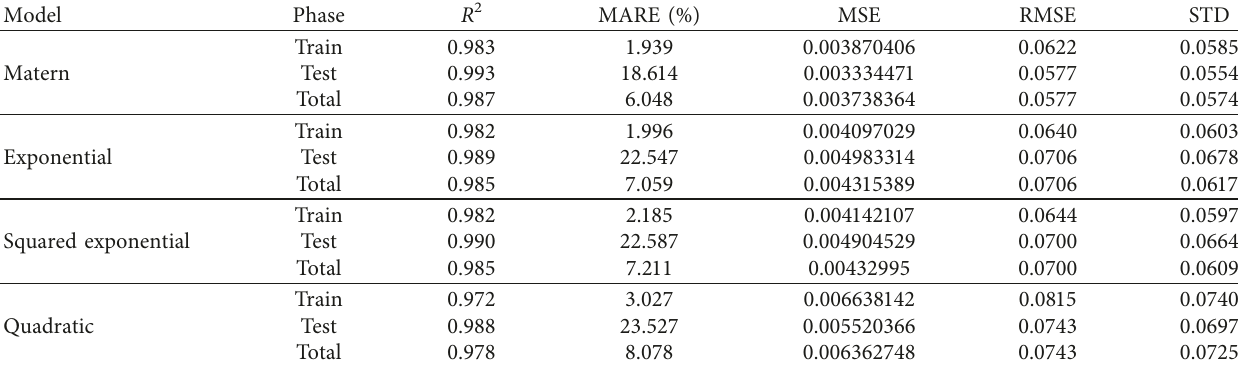
Table 1: Different statistical parameters of the proposed models in order to determine their accuracy in predicting the target parameter. Model Phase R 2 MARE (%) MSE RMSE